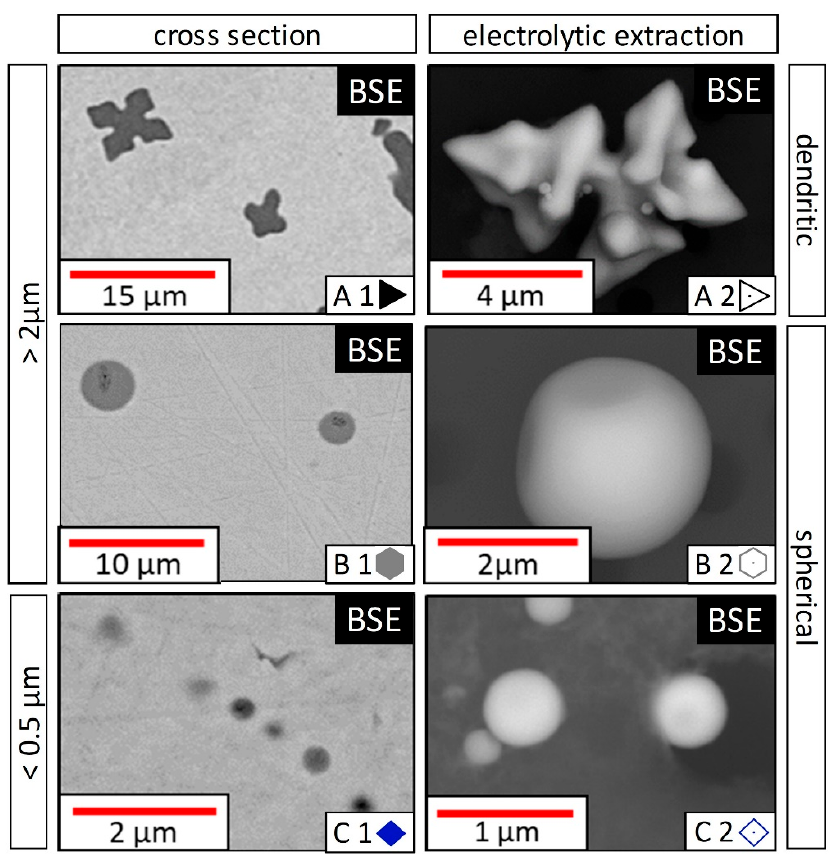
Figure 4. Inclusion classes categorized by morphology and size.